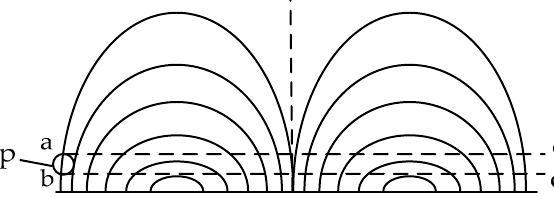
Figure 3. Rotating magnetic field component during the translation of a traveling wave magnetic field.